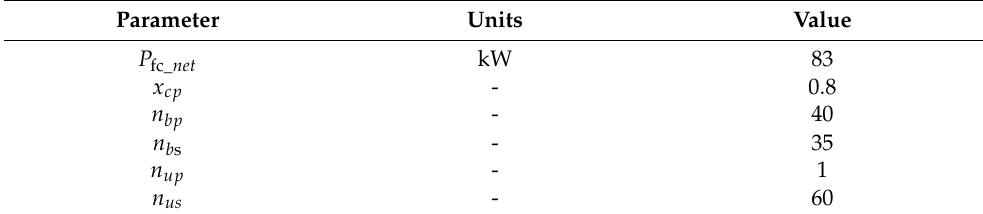
Table 7. Results of the optimal design.